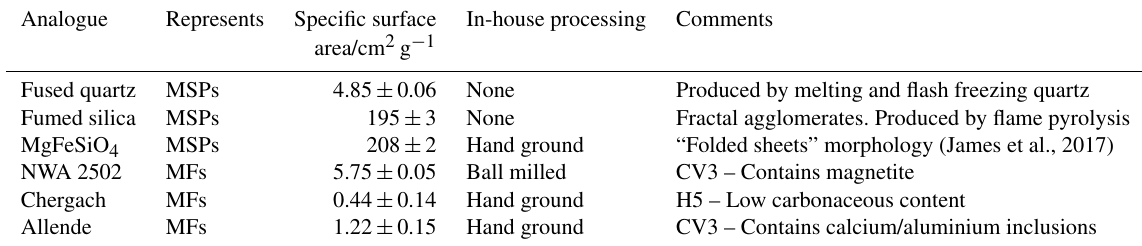
Table 1. Description of analogue samples. Analogue Represents Specific surface In-house processing Comments